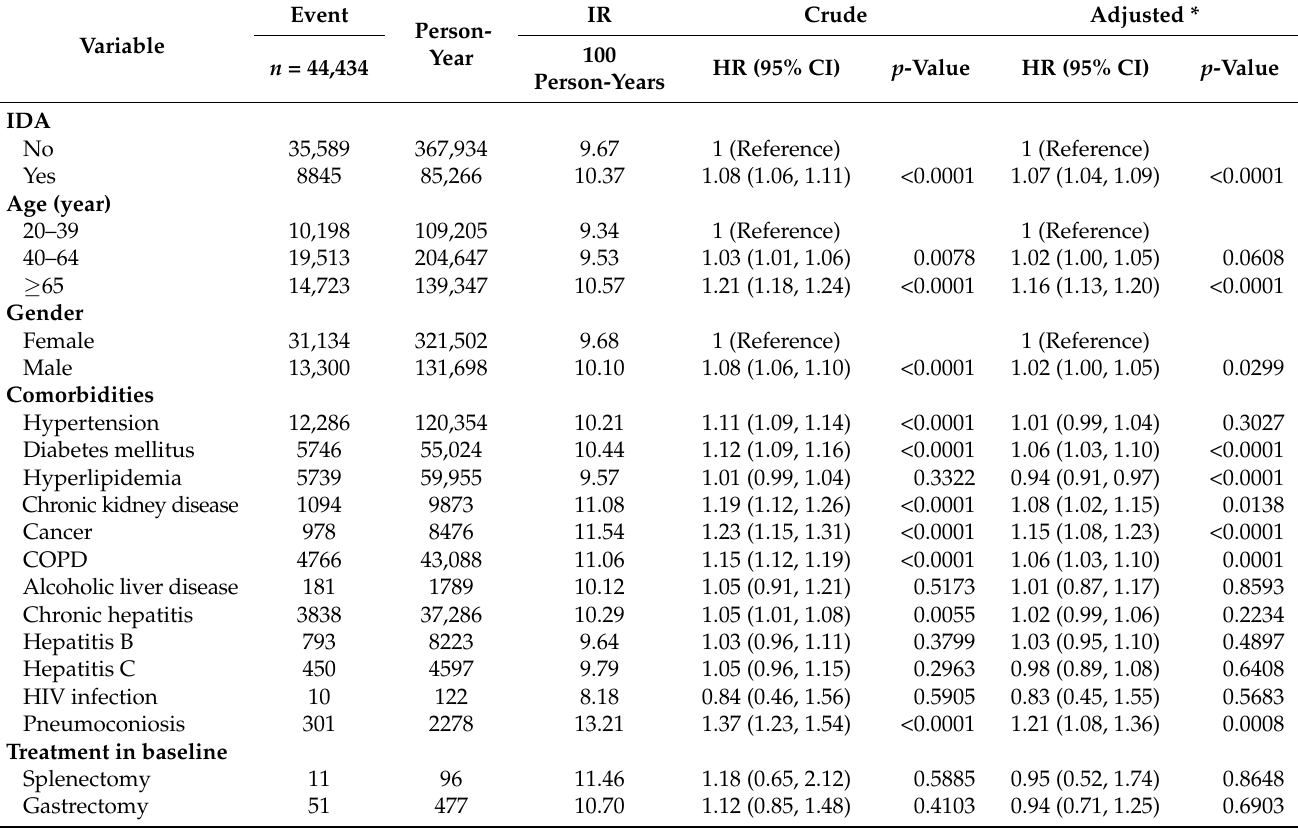
Table 5. The sensitivity of IDA patients to infections other than